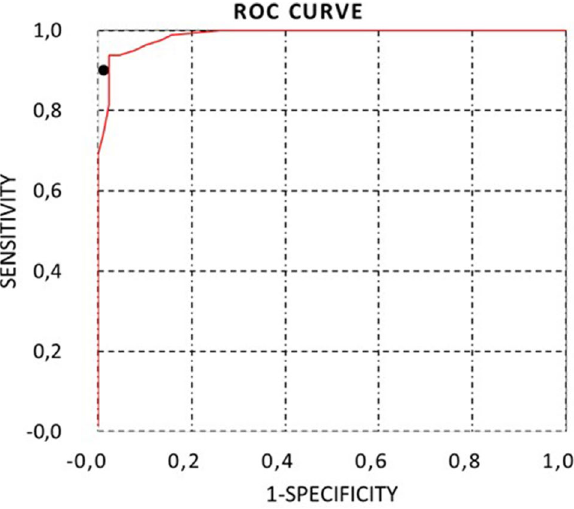
Figure 5. ROC curve of the H/CL index using a cut-off point of 1.3 to classify patients as suggestive of TTR-CA, inconclusive, or not suggestive of TTR-CA. The sensitivity and specificity of the visual evaluation have been represented with a black